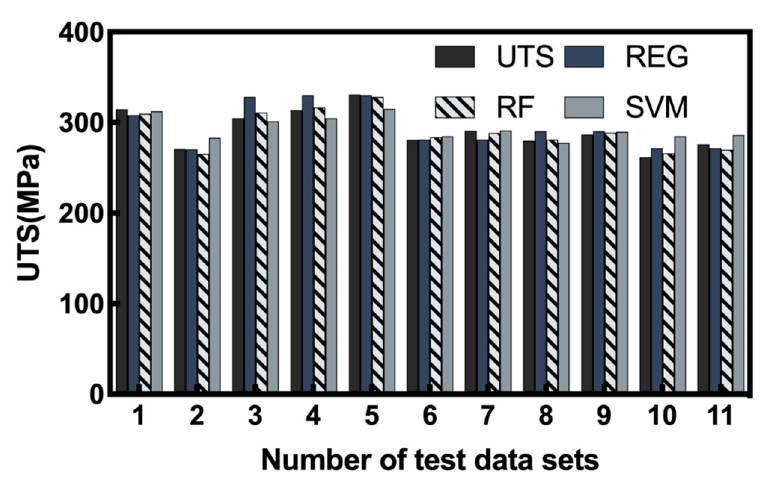
Figure 13. Actual vs. number of test data sets.